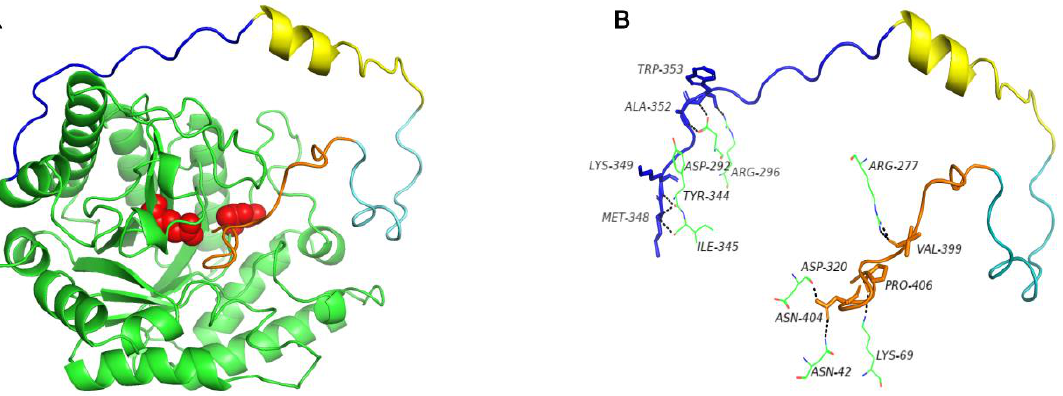
Figure 3. Three-dimensional protein structure model of XynA ( A ) and the molecular interactions between C60 and XynA-Tr ( B ). XynA-Tr is colored in green, the four parts of C60 are marked in dark blue, yellow, light blue, and orange, respectively. The black dashed line represents the molecular interactions.